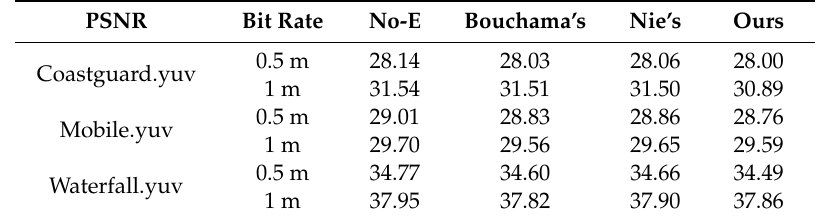
Table 5. Video quality experimental results.